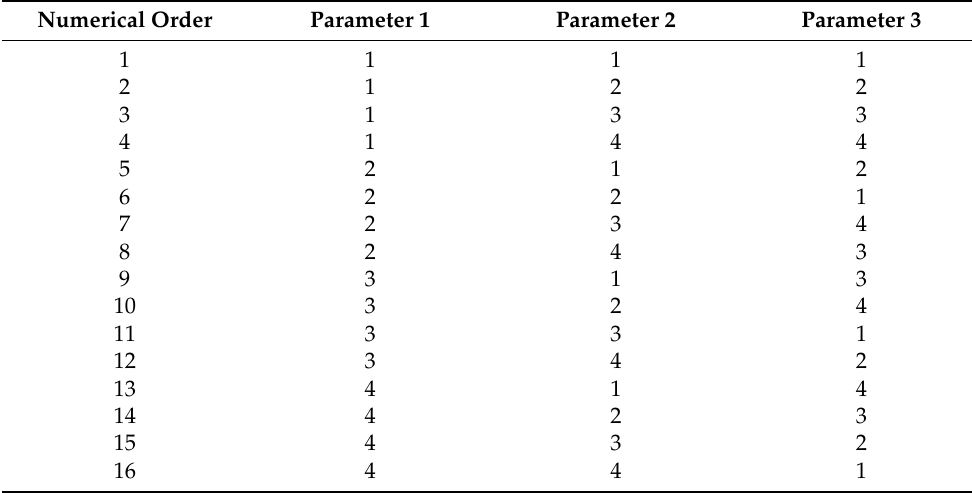
Table 2. Value combinations of three-parameter four-level orthogonal test.